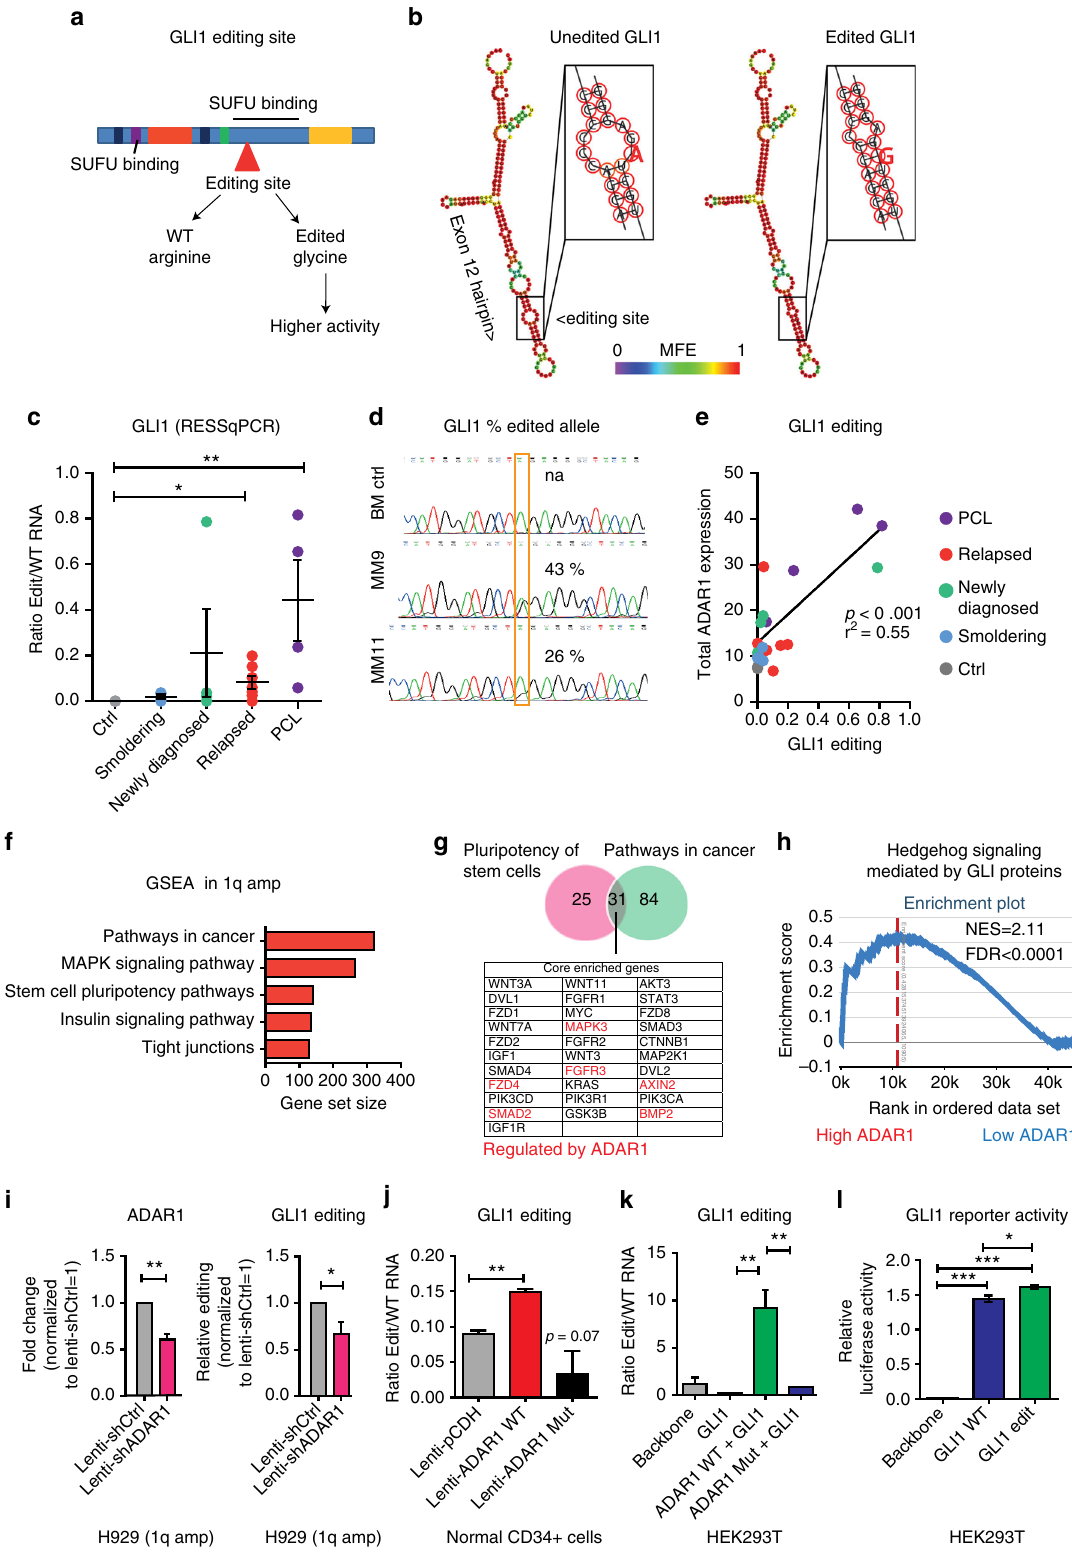
NATURE COMMUNICATIONS | 8: